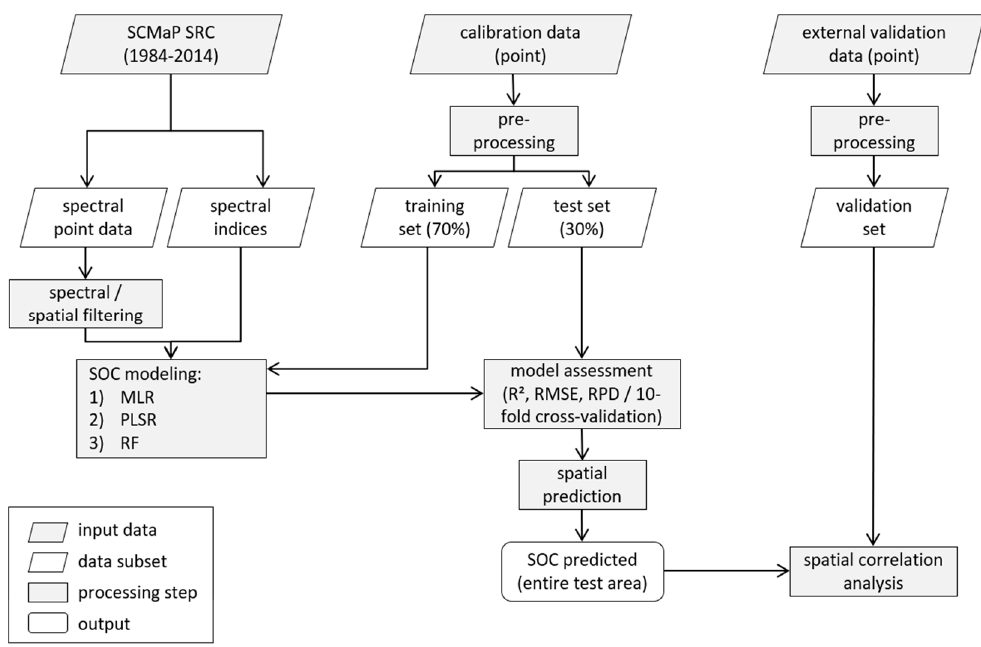
Figure 2. A flowchart of the SOC modeling approach (SRC—soil reflectance composite; MLR—Multiple Linear Regression; PLSR—Partial Least Square Regression; RF—Random Forest; RMSE—Root Mean Square Error; RPD—Ratio of Performance to Deviation).